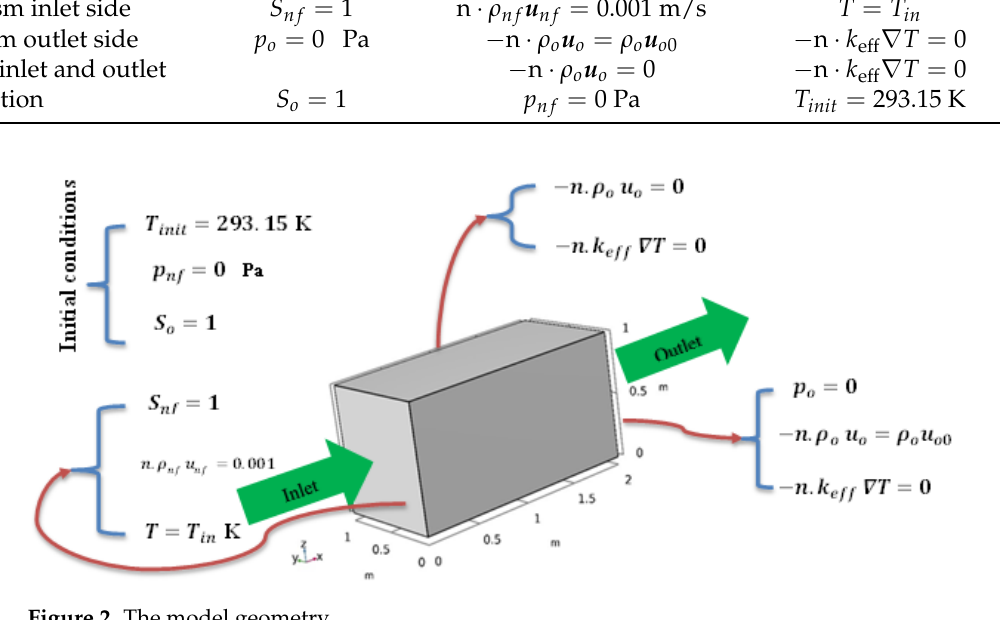
Figure 2. The model